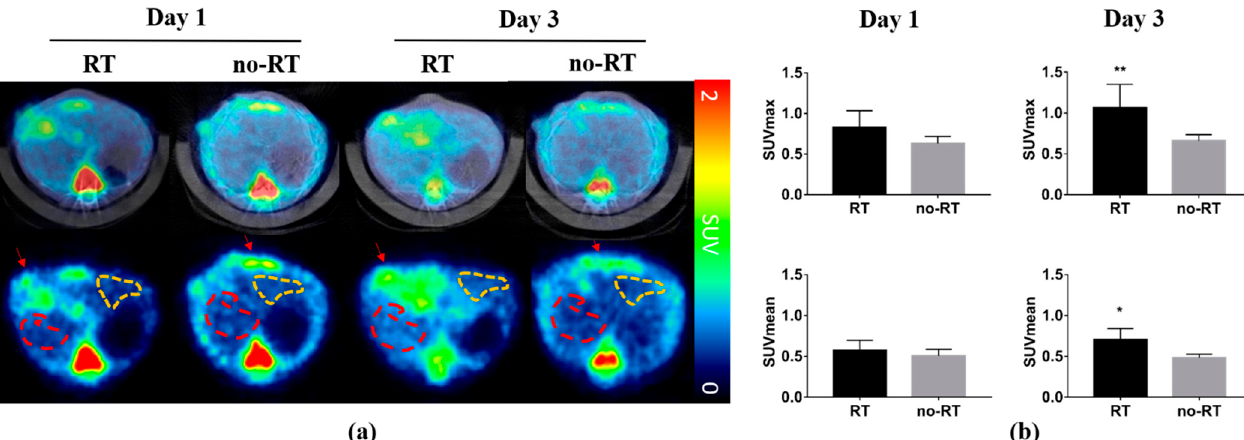
Figure 1. Impact of liver irradiation on 18F-FDG uptake by the areas surrounding orthotopic hepatocellular carcinomas in the right liver. ( a ) Representative transaxial images of fused PET/CT (upper row) and PET only (lower row) obtained in the RT ( n = 5) and no-RT ( n = 5) groups on the first and third post-irradiation days. Red and yellow dashed lines indicate the areas in the right and left liver lobes taken into account for the purpose of analysis. Red arrows indicate the experimental tumors. ( b ) SUVmean and SUVmax values measured in the right hepatic parenchyma on the first and third post-irradiation days. On the third post-irradiation day, both SUVmean and SUVmax values were significantly increased in the RT group, as compared with the no-RT group. * p < 0.05; ** p < 0.01